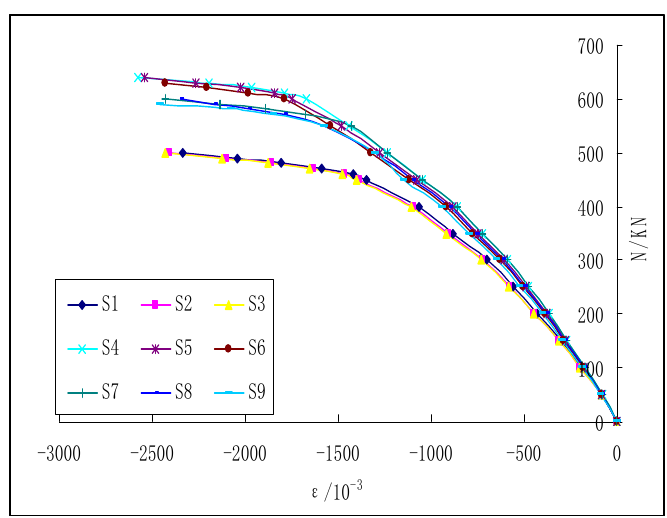
Figure 8. The average strain curve of the concrete.